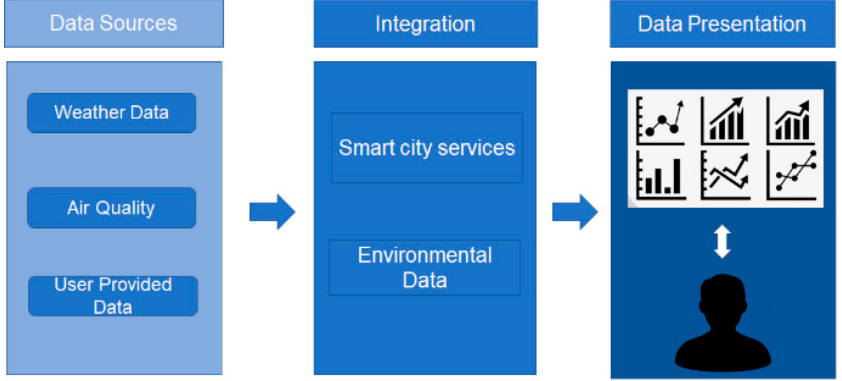
Figure 4. Preliminary concept of the smart city service.